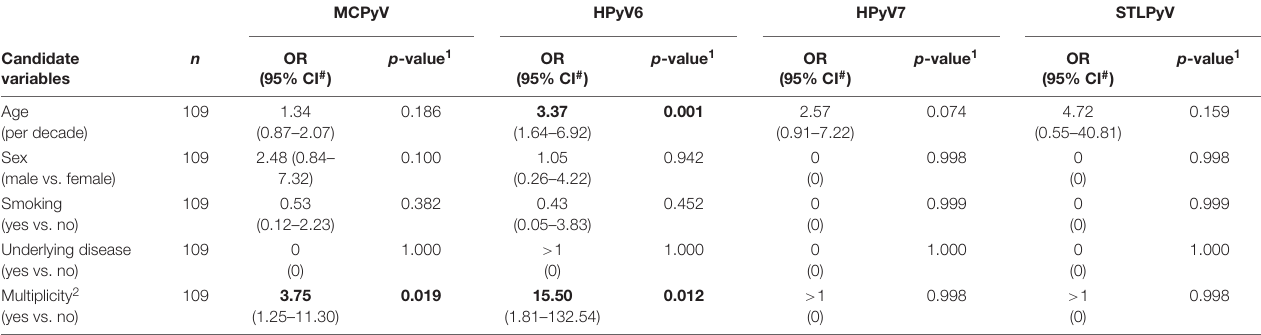
TABLE 7 | Risk factors for HPyVs short-term persistence on the forehead of healthy individuals found in univariable logistic regression analysis. MCPyV HPyV6 HPyV7 HPyV10 STLPyV